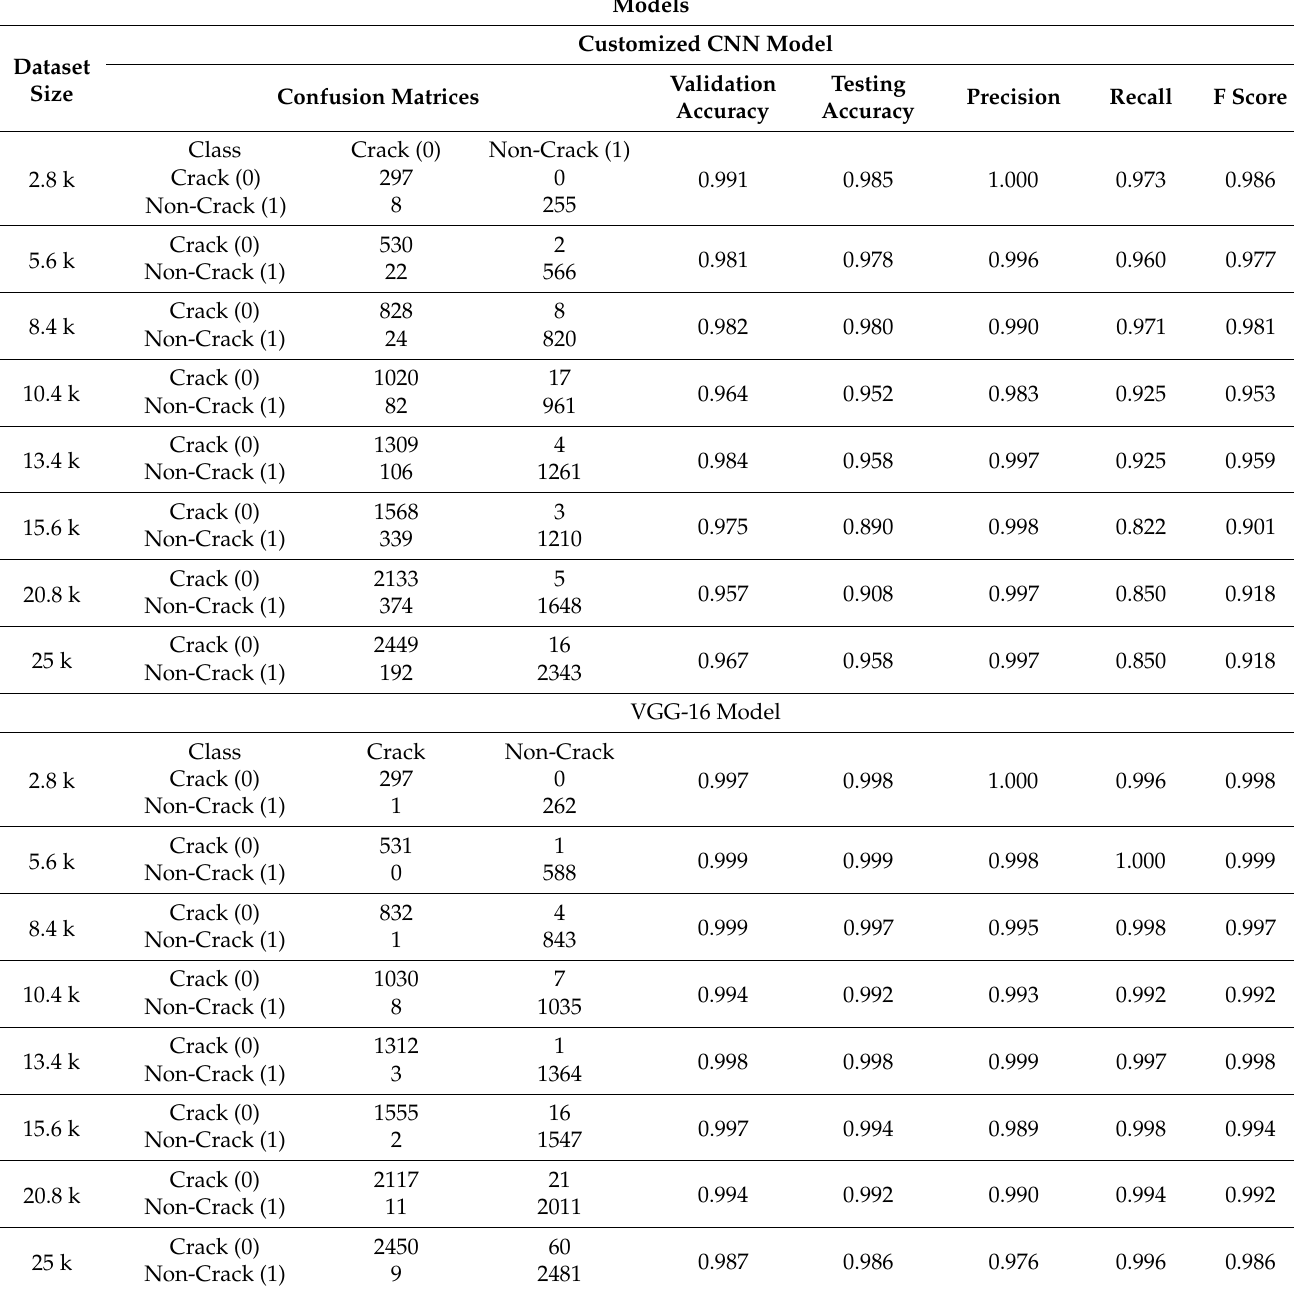
Table 3. Experimental results of all